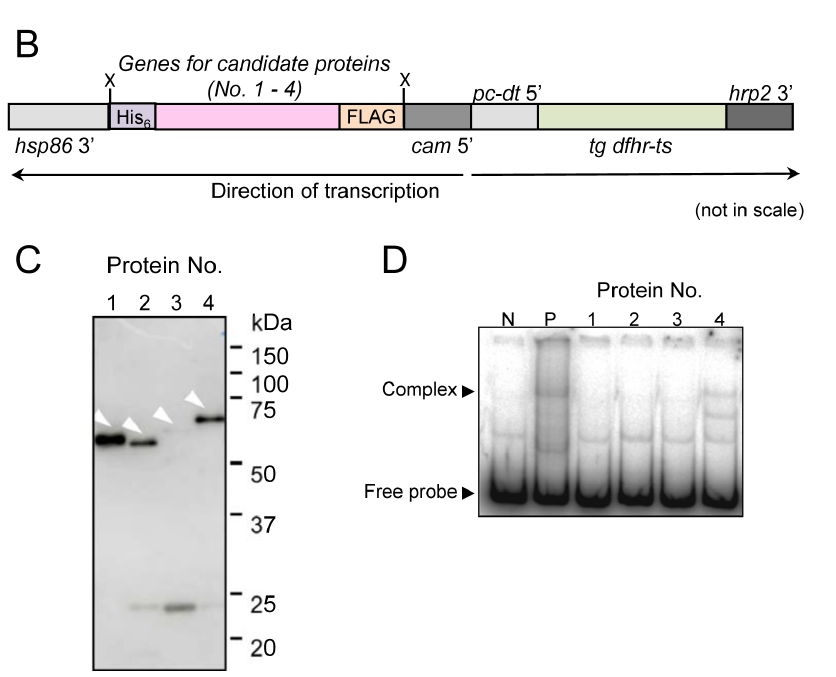
Figure 2. Preparation of the recombinant candidate proteins using gene overexpression system in P. falciparum . (A) Detailed descriptions for each candidate protein. (B) Schematic diagram of plasmid constructs used for the gene overexpression in P. falciparum . Genes for candidate protein Nos. 1, 2, 3 and 4 were inserted into the expression site of the pHC1 vector. For protein purification, the FLAG-tag and His-tag were added to the N and C termini, respectively. The restriction endonuclease recognition sequences shown is X, Xho I. (C) Immunopurification of the recombinant proteins from transgenic parasites. Expressed recombinant proteins were immunopurified with the anti-FLAG antibody and subjected to Western blotting with anti-FLAG antibody. The bands corresponding to the recombinant proteins are indicated with white arrowheads. Sizes are indicated in kDa on the left. (D) EMSA with partially purified recombinant proteins. The same labeled probe was used in Figure 1 in each assay. Lane N is probe only. EMSA was performed with 0.1 m g of each fraction of immunopurified recombinant protein. Lane P is the positive control for the assay with 0.6 m g of nuclear extract derived from the parasite synchronized at the trophozoite/schizont stage. Positions of the free probe and the shifted band are indicated on the